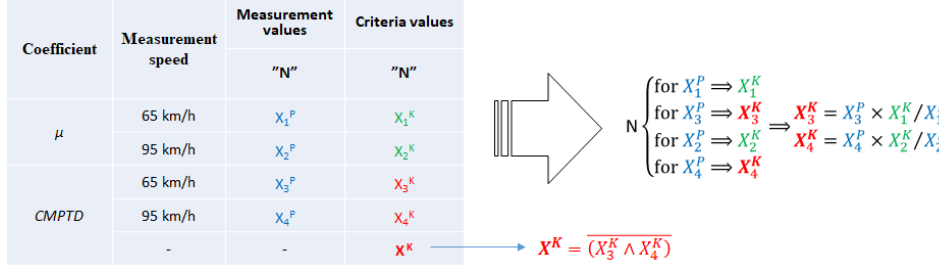
Figure 7. Determination of the search criteria—two ratios put into an equation method.